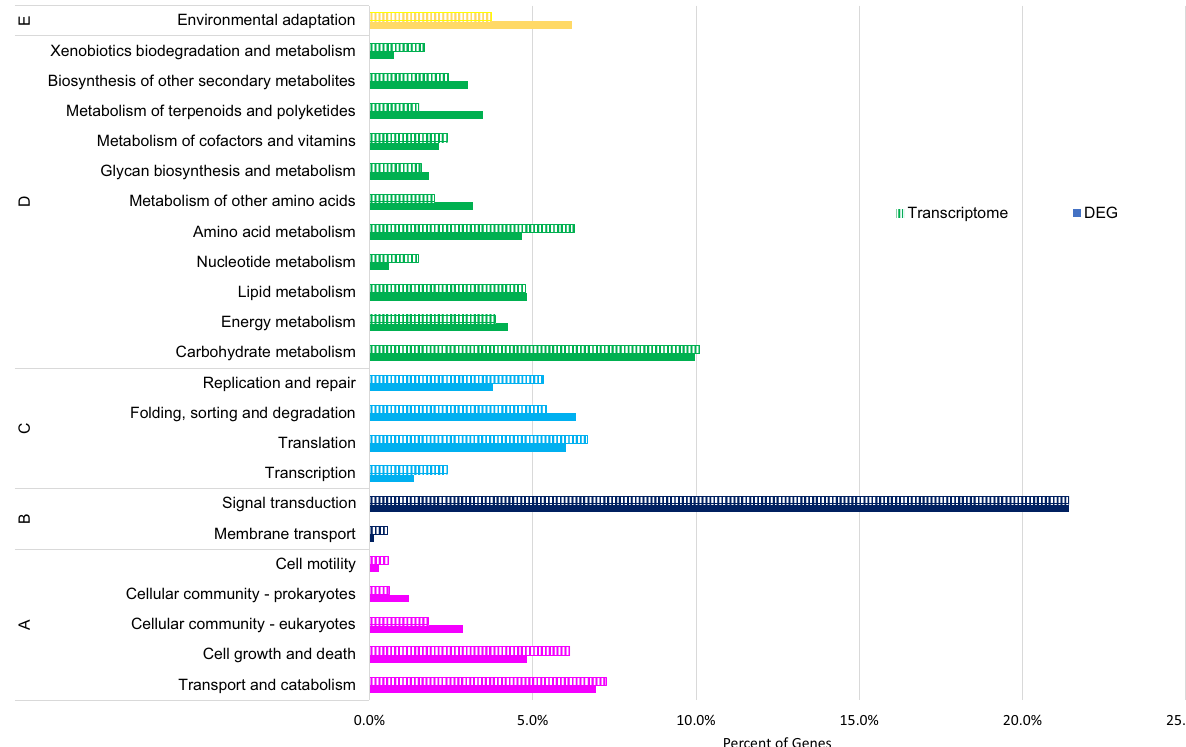
Figure 3. KEGG classification of unique sequences in both entire transcriptome (dashed line) and differentially expressed contigs (solid line). (A) Cellular processes; (B) Environmental information processing; (C) Genetic information processing; (D) Metabolism; and (E) Organismal systems. A total of 65,879 unique sequences were classified in the KEGG database.